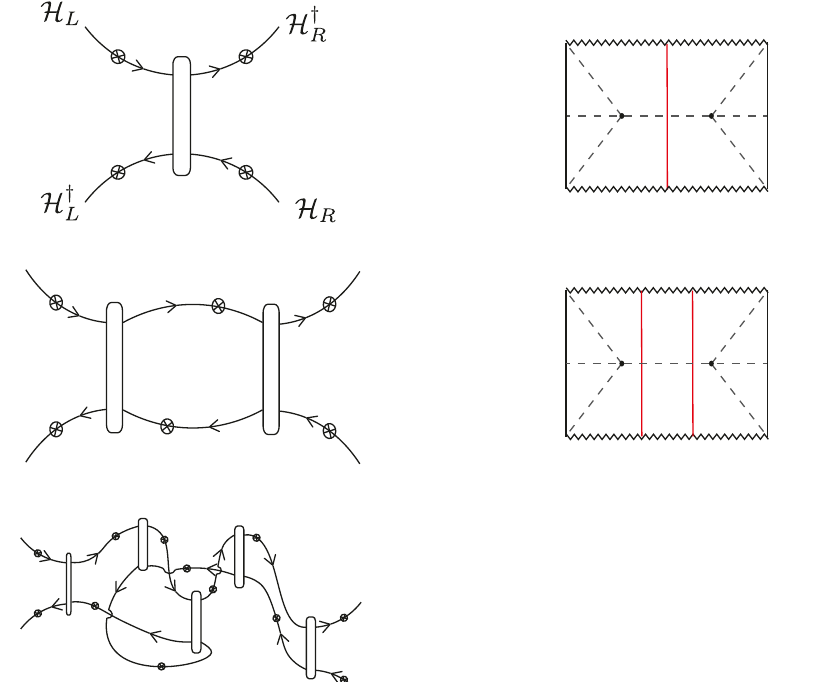
Figure 3 : Single shot density matrix (first line), multishot density matrix (2nd line) and a more general wormhole (third